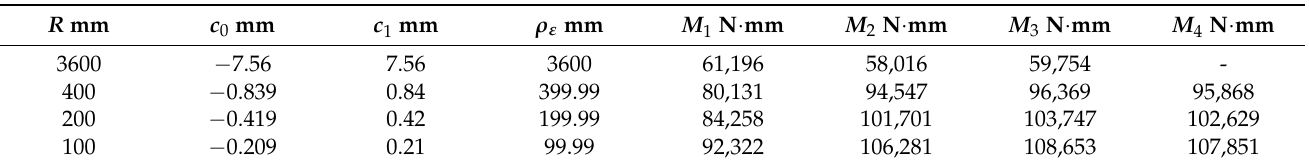
Table 2. Comparison of section deformation parameters between analytical model, SFEM, FEM, and actual sample